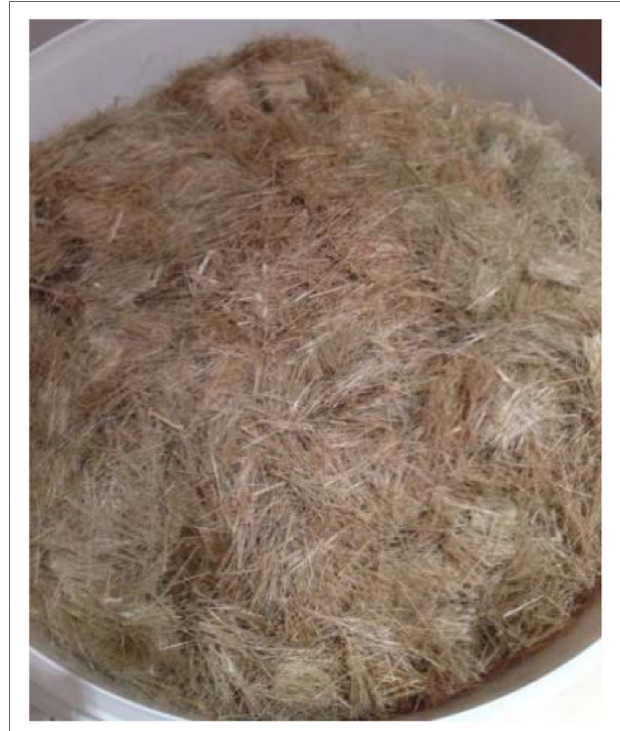
FIGURE 1 | Fifteen-millimeter length hemp fibers.